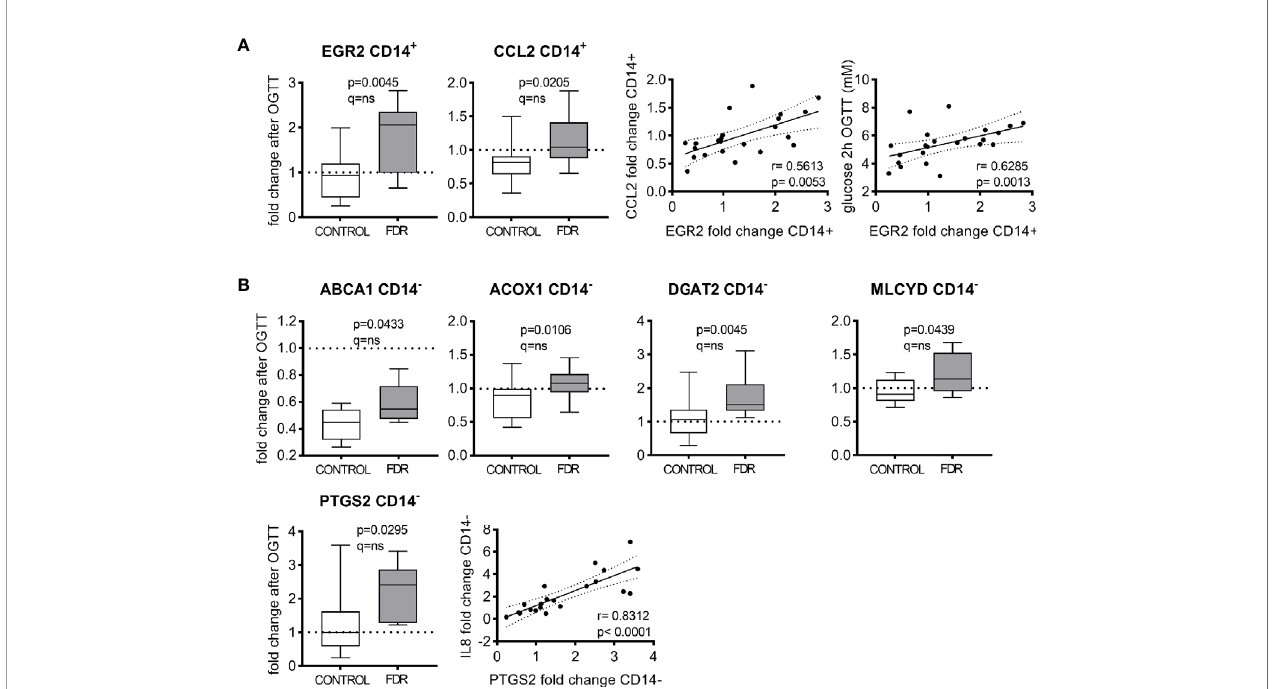
FIGURE 2 | Effect of group (FDR vs controls) on oral glucose tolerance test (OGTT) – induced gene expression changes in circulating CD14 + (A) and CD14 - PBMC (B) . The effect is presented as fold change (OGTT vs. basal) in each group. Gene expression was normalized to the geomean of reference genes RPS13 and TBP. Box plots show the medians with 25 th and 75 th percentiles, whiskers show min and max values. Effects of OGTT on mRNA levels within individual groups were evaluated by Multiple Mann-Whitney tests, with multiple comparisons by False Discovery Rate (method by Benjamini, Krieger, and Yekutieli). Correlations of changes in gene expressions (fold change) and glucose levels at the end of OGTT (Spearman rank-order correlation coef fi cient) are shown. Level of signi fi cance for both p and q value was set to